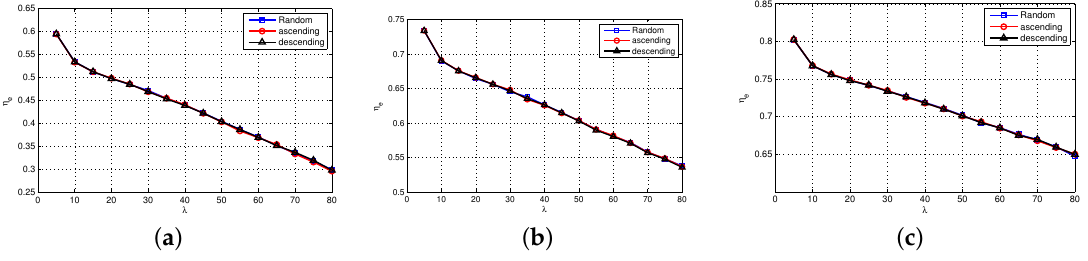
Figure 14. Different processing sequence in random topologies. ( a ) D = 4. ( b ) D = 6. ( c ) D =